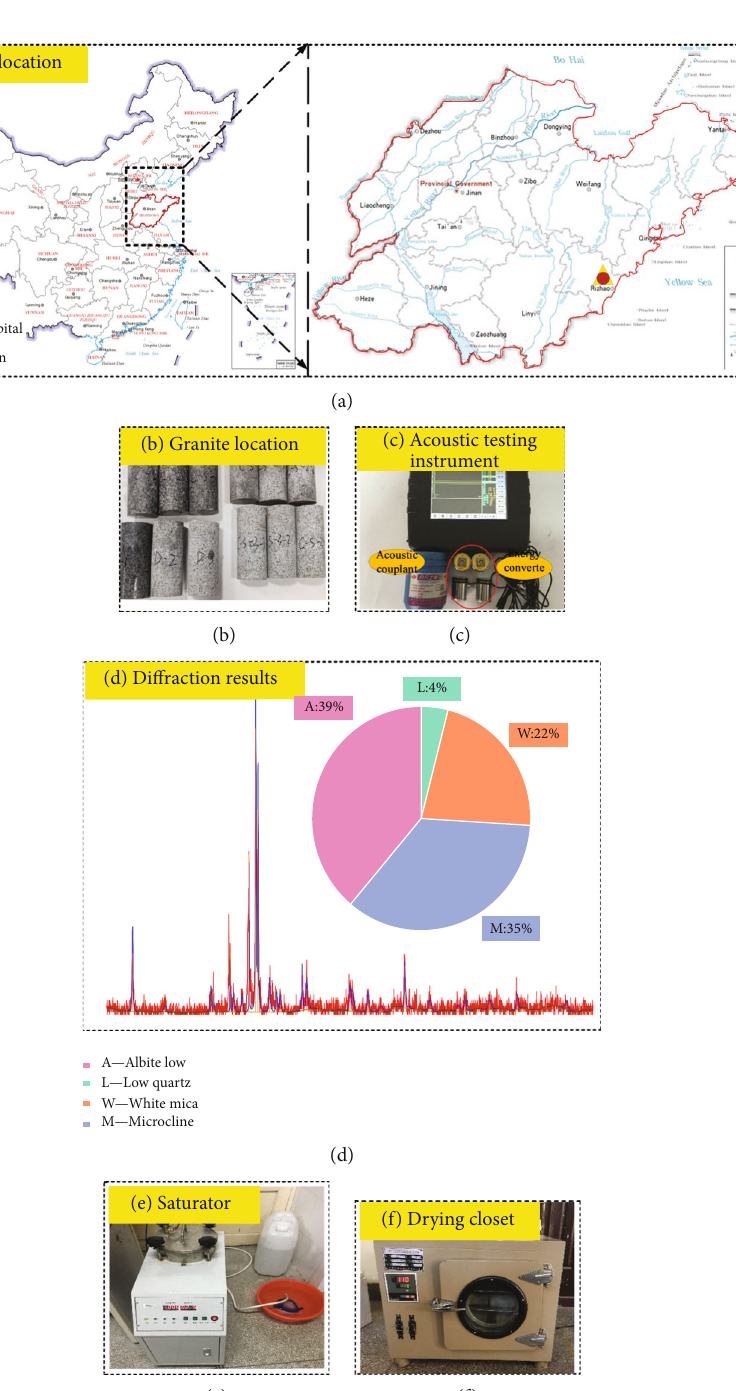
Figure 1: Sampling site and sample preparation for coarse-grained granite and related